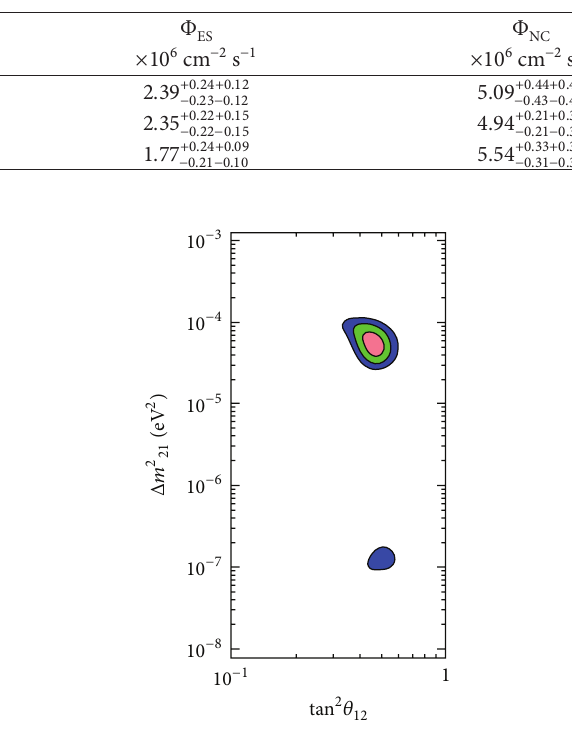
Figure 7: Allowed regions (68.27%, 95.45%, and 99.73% C.L.) in the oscillation parameter plane obtained fitting the Homestake + GALLEX+Super-Kamiokande+SNOdataintheframeoftheMSW model. Note that these results are based on solar neutrinos only, without considering KamLAND antineutrino data. From